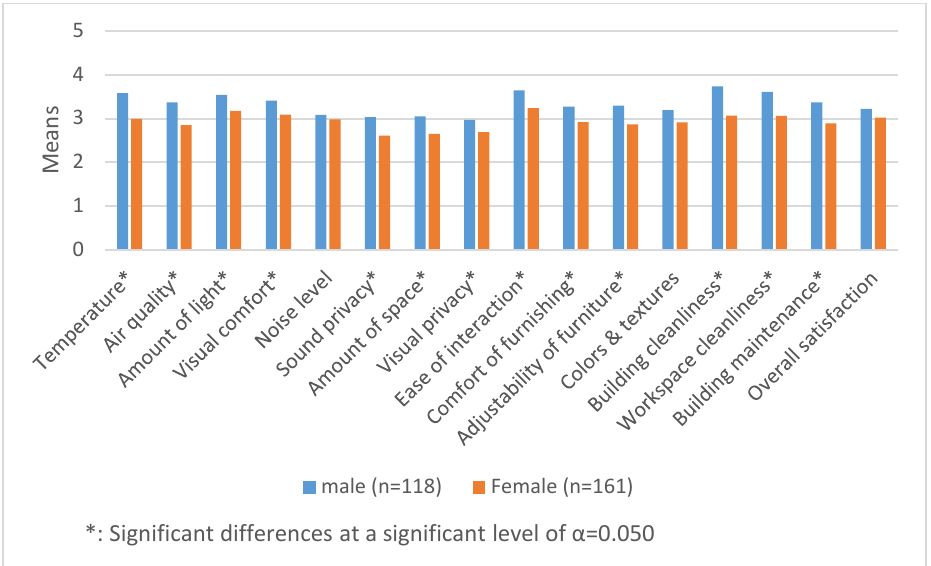
Figure 1. The impact of gender on satisfaction with IEQ factors.